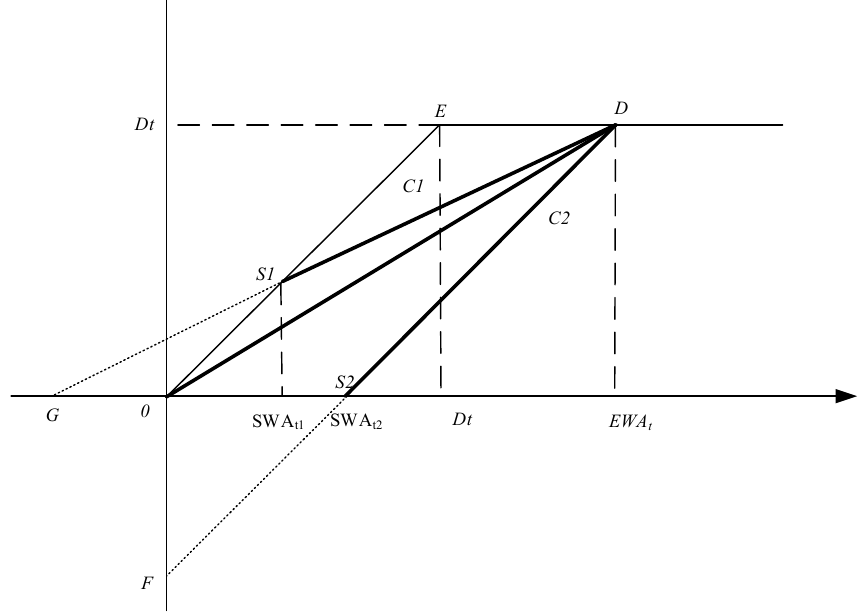
Figure 1. The hedging rules and the standard operating policy.